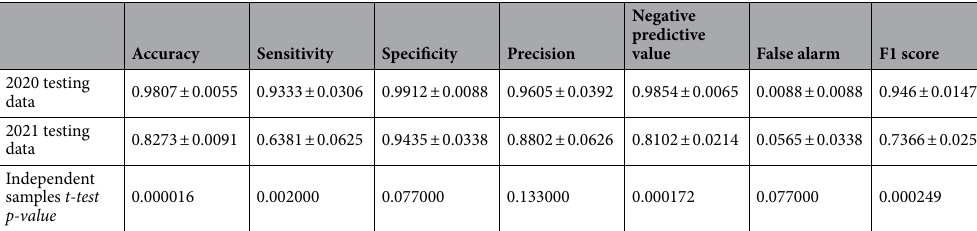
Table 1. Comparison of the testing data from 2020 (n = 273, of which 226 were normal and 47 treated) with the testing data from 2021 (n = 276). Both were trained by the same model on XGBoost using compositional training data from 2020 (n = 1002, of which 821 were normal and 181 were treated). Comparison of the prediction model was performed using independent sample t-test on SPSS.